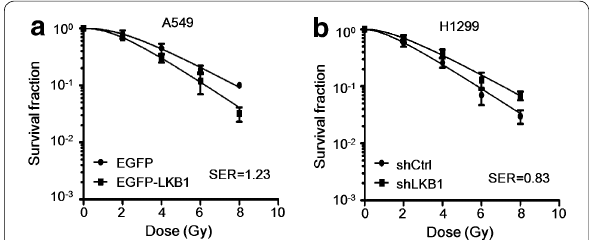
Fig. 6 LKB1 increased the radiosensitivity of A549 and H1299 cells. The radiosensitivity was evaluated by clonogenic cell survival assay. a , b A549 cells were transfected with EGFP or EGFP‑LKB1, and H1299 cells were transfected with shCtrl or shLKB1, and all were irradiated with the indicated dose. After 14 days, the colonies formed by the surviving cells were counted. The survival fraction was normalized to the non‑irradiated controls and presented as mean SD. The survival ± curves were fitted to a linear‑quadratic model using GraphPad Prism 5.0 software. Re‑expression of LKB1 in A549 cells increased the sensi‑ tizer enhancement ratio (SER) to 1.23, whereas knockdown of LKB1 in H1299 cells decreased the SER to